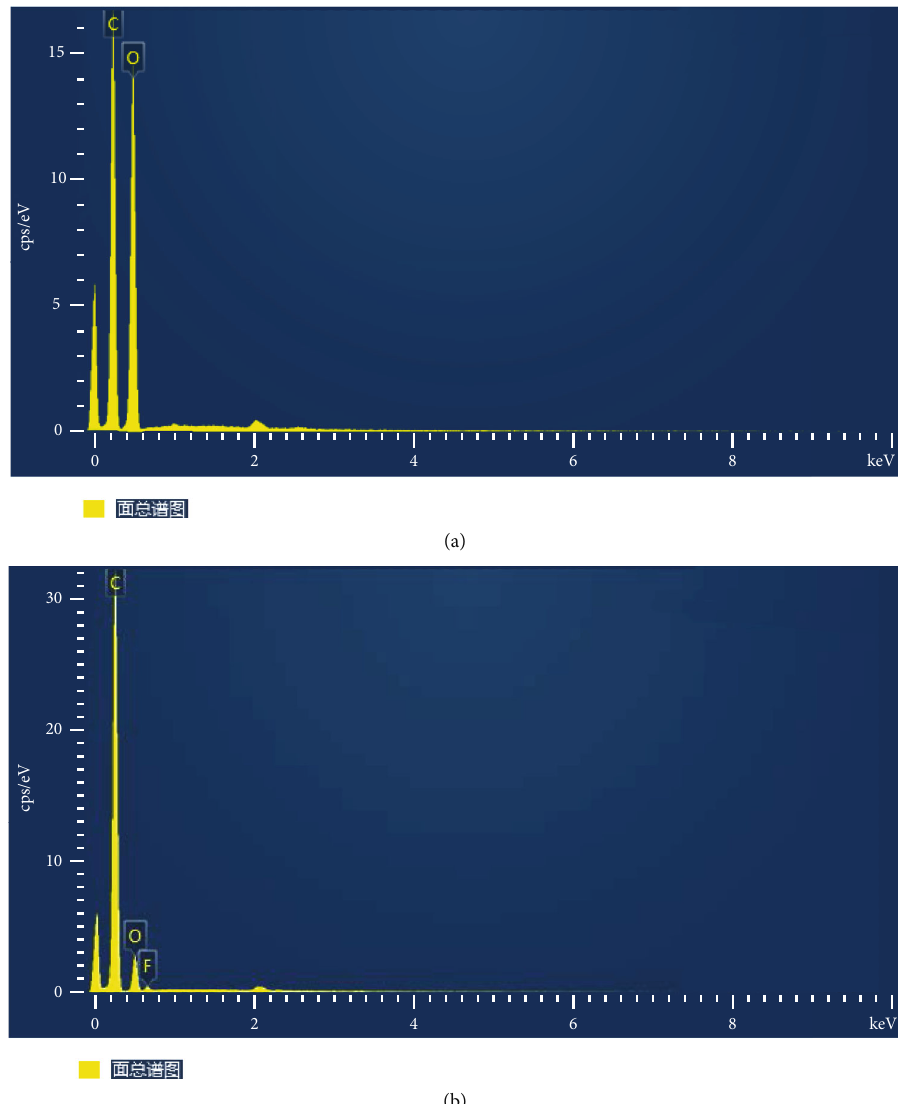
Figure 4: (a) EDS plot of the monomer. (b) EDS plot of the polymer.